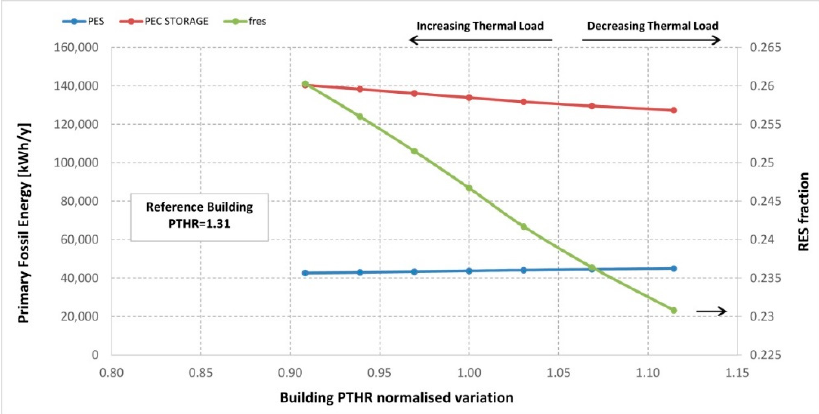
Figure 14. Sensitivity analysis on Performance indicators with changes in Thermal loads when a batteries bank is connected.